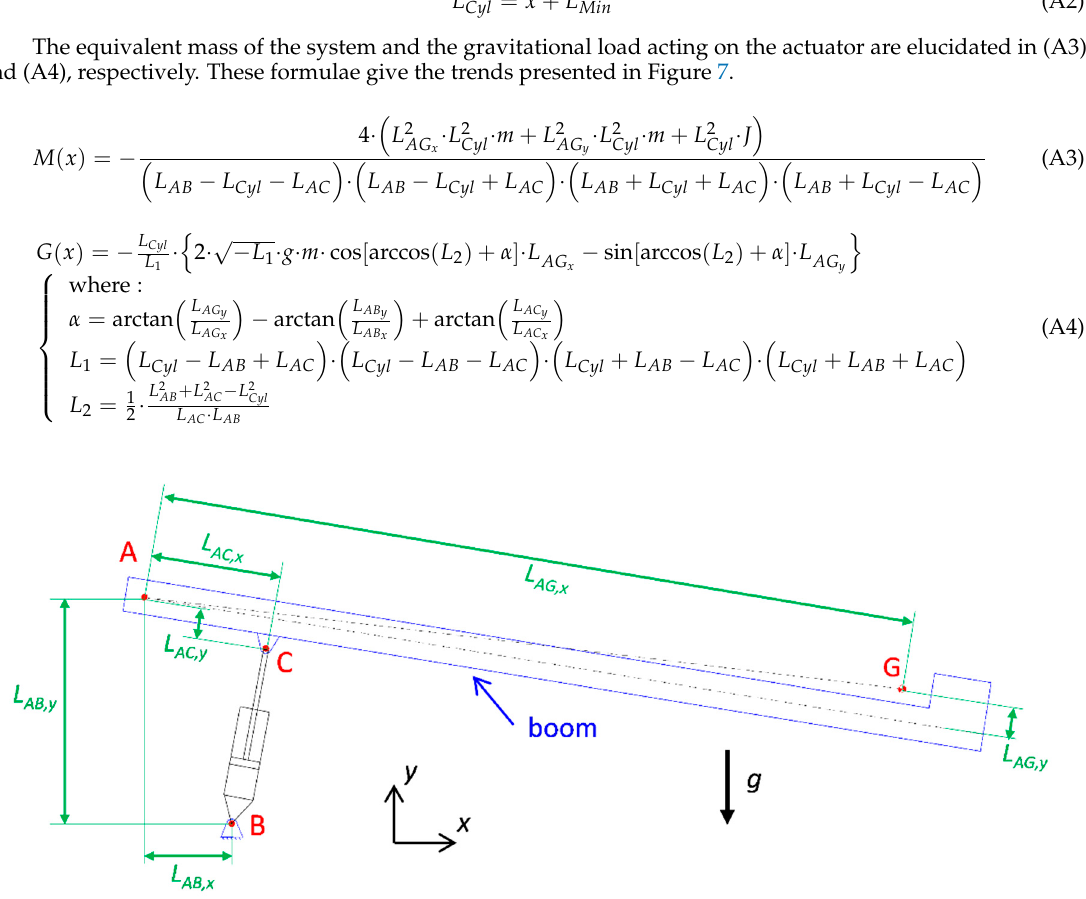
Table 3. Key parameters of the single-boom crane. Magnitude